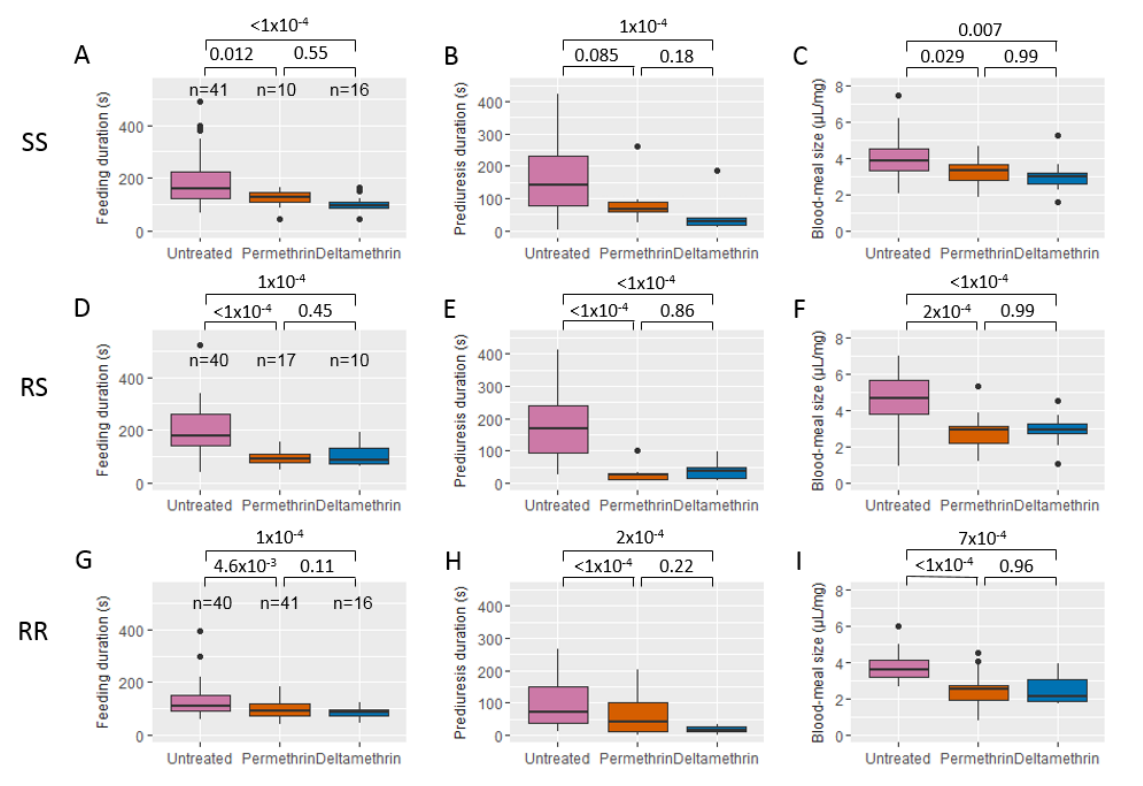
Figure 4. Biting behavior after exposure to insecticides of Anopheles gambiae females of each kdr genotype. Boxes-and-whiskers plots of feeding duration (panels A, D and G), prediuresis duration (panels B, E and H) and blood-meal size (panels C, F and I) are shown for each genotypes SS (panels A, B and C), RS (panels, D, E and F) and RR (panels G, H and I). Boxes indicate 1st-3rd quartile and median values. Whiskers indicate 1.5 inter-quartile range. Numbers n of blood-fed mosquitoes for each genotypes and tested for behavioural parameters are indicated in panels A, D and G. P-values according to Tukey’s test after mixed-effect cox proportional hazard model (panels A, B, D, E, G and H) and after linear mixed effect model (panels D, F and I) are